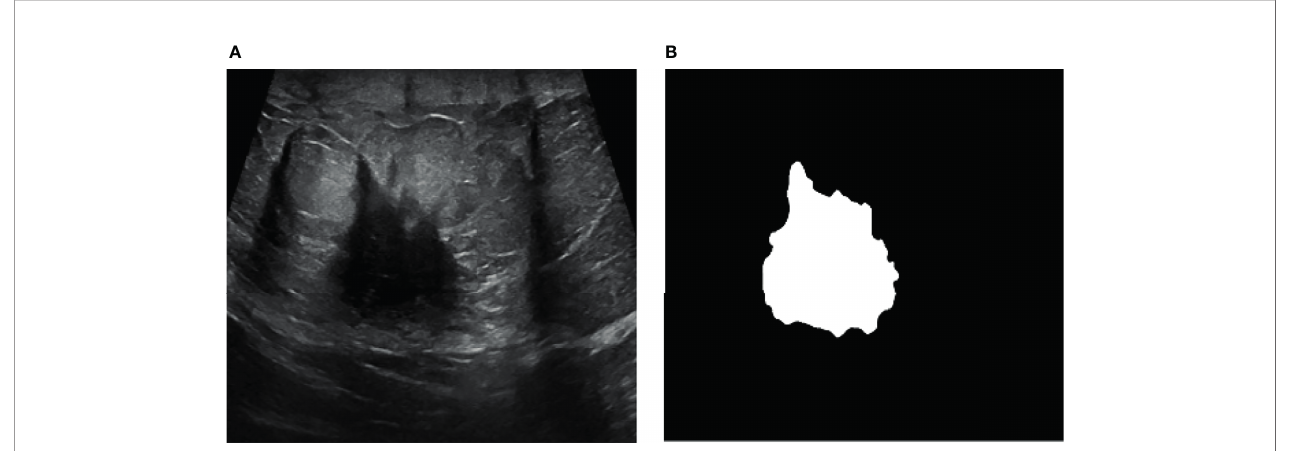
FIGURE 4 | ROI segmentation. (A) Ultrasound image and (B) segmented